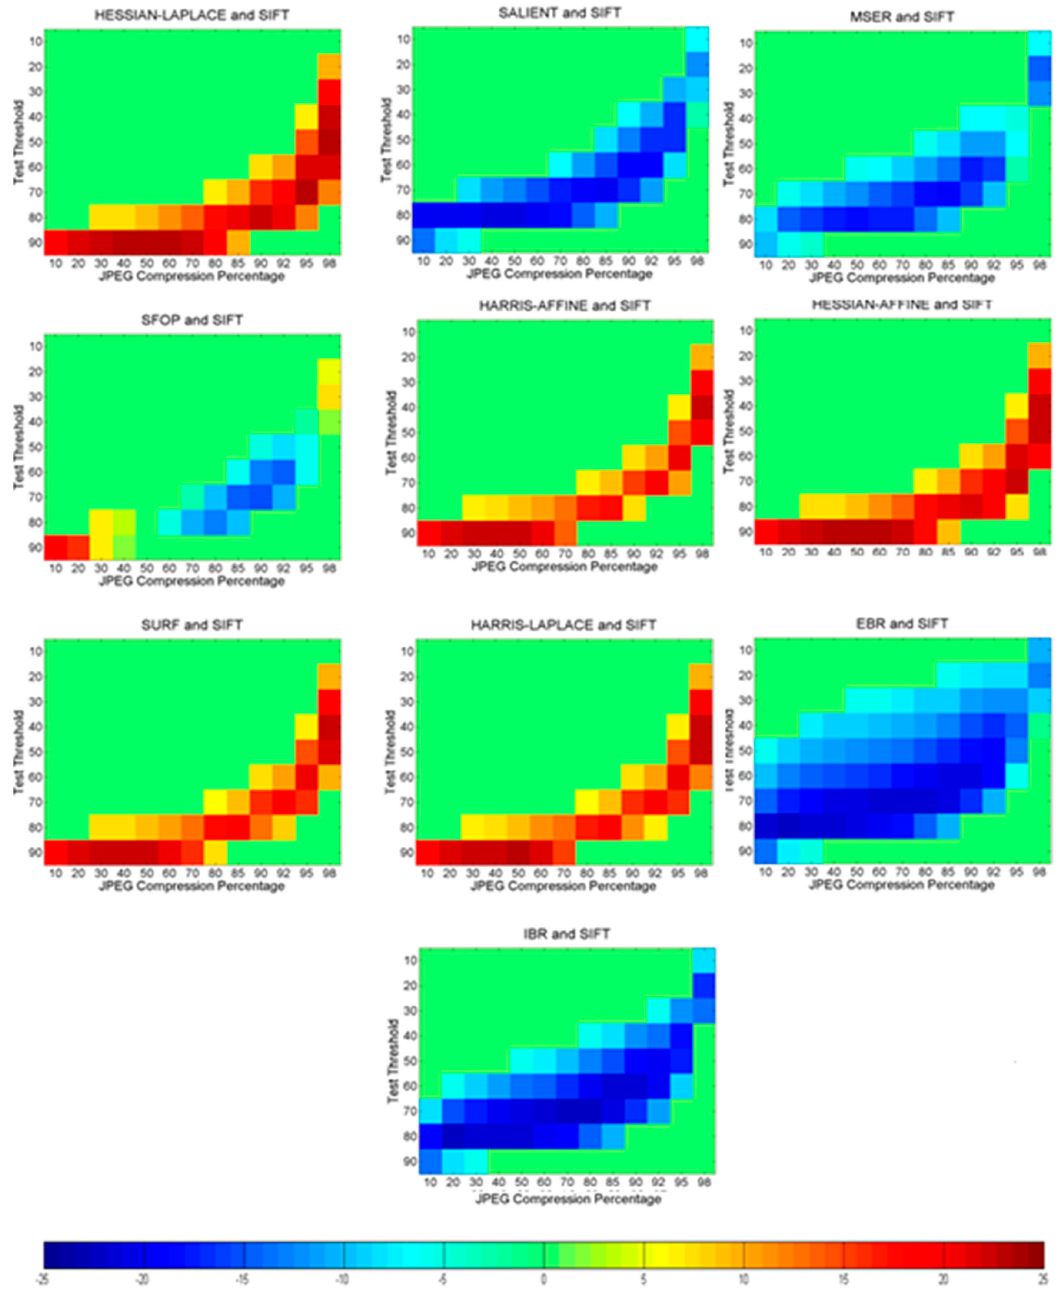
Figure 12. JPEG compression results for SIFT with the other detectors showing Z -scores obtained; positive Z -scores indicate that the first detector is better than the second whereas the negative values show the converse.